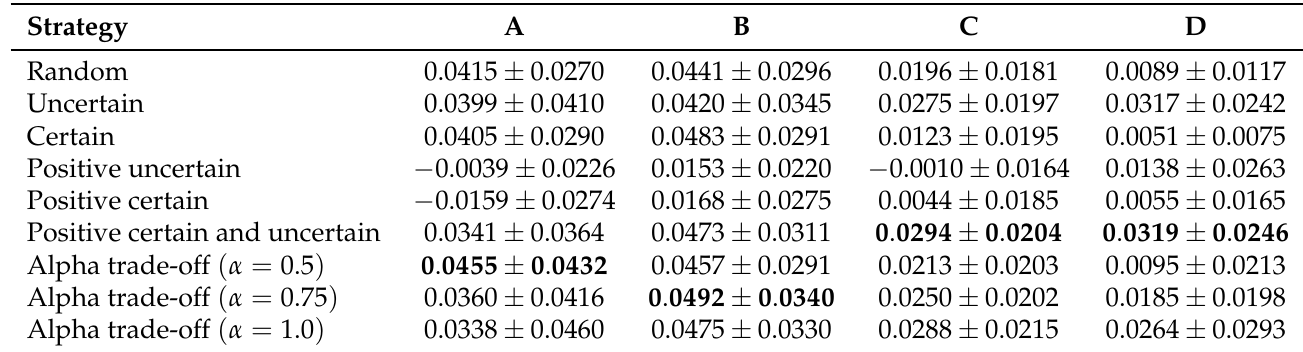
Table 7. Mean change in ROC AUC score with standard deviation, aggregated over used models and representations, for each strategy, reported on each of the four datasets. The best score for each dataset is shown in bold. A–D correspond to the four datasets we used to conduct the experiments, which are described in Table 2. It shows the change in performance when models trained on initialization set are trained with